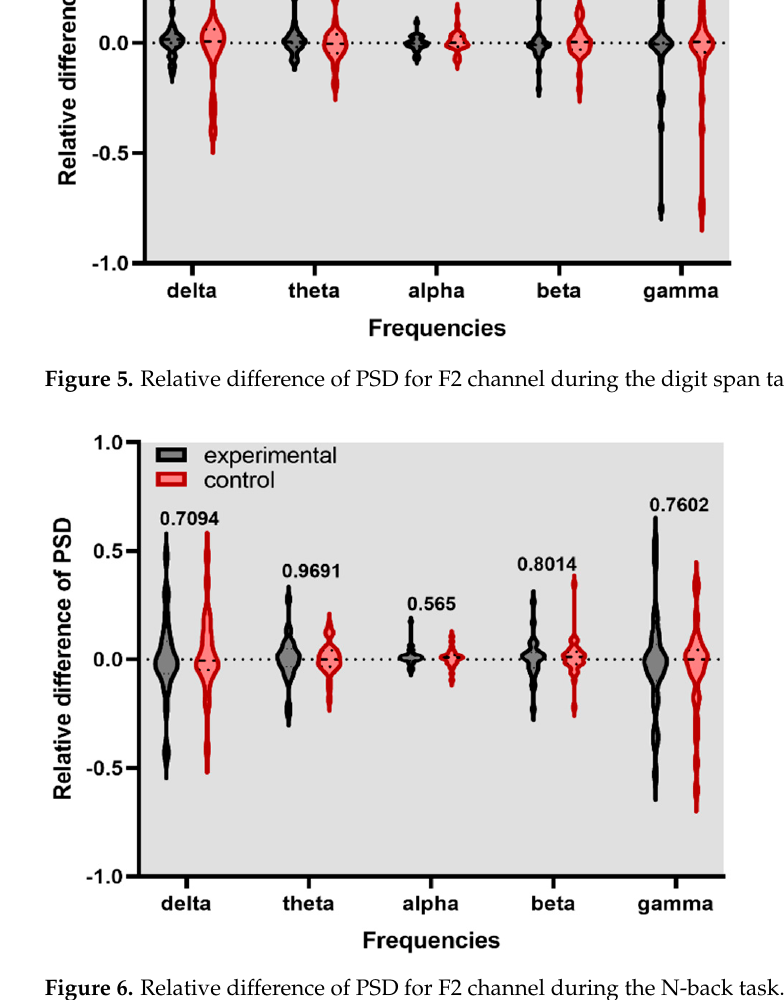
Figure 6. Relative difference of PSD for F2 channel during the N-back task.